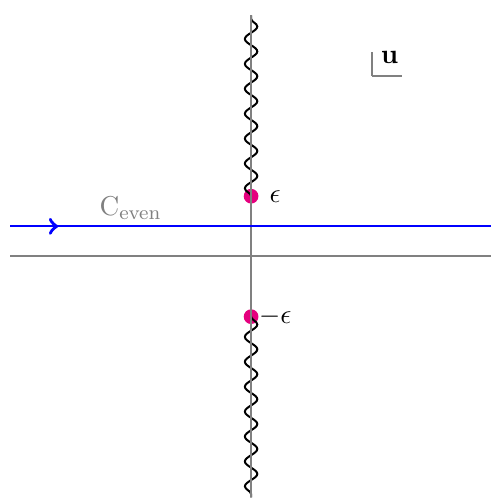
Figure 3 . Contour C even in the u -plane for even AdS b .